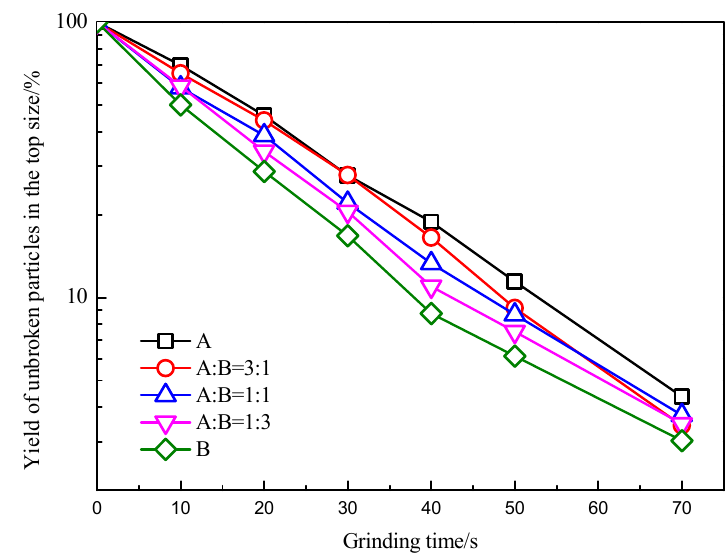
Figure 3. Yield of unbroken particles in the top size for various grinding times.